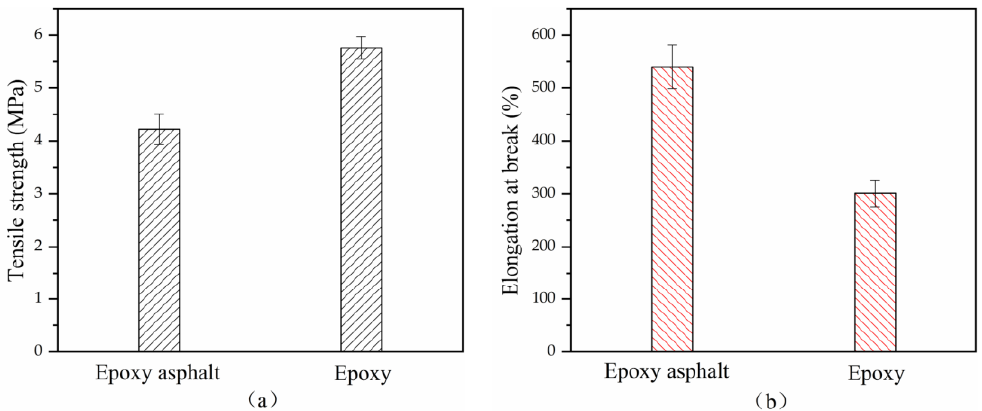
Figure 2. Comparison of the mechanical properties of fully cured epoxy asphalt and pure epoxy resin: (a) tensile strength and (b) elongation at break.